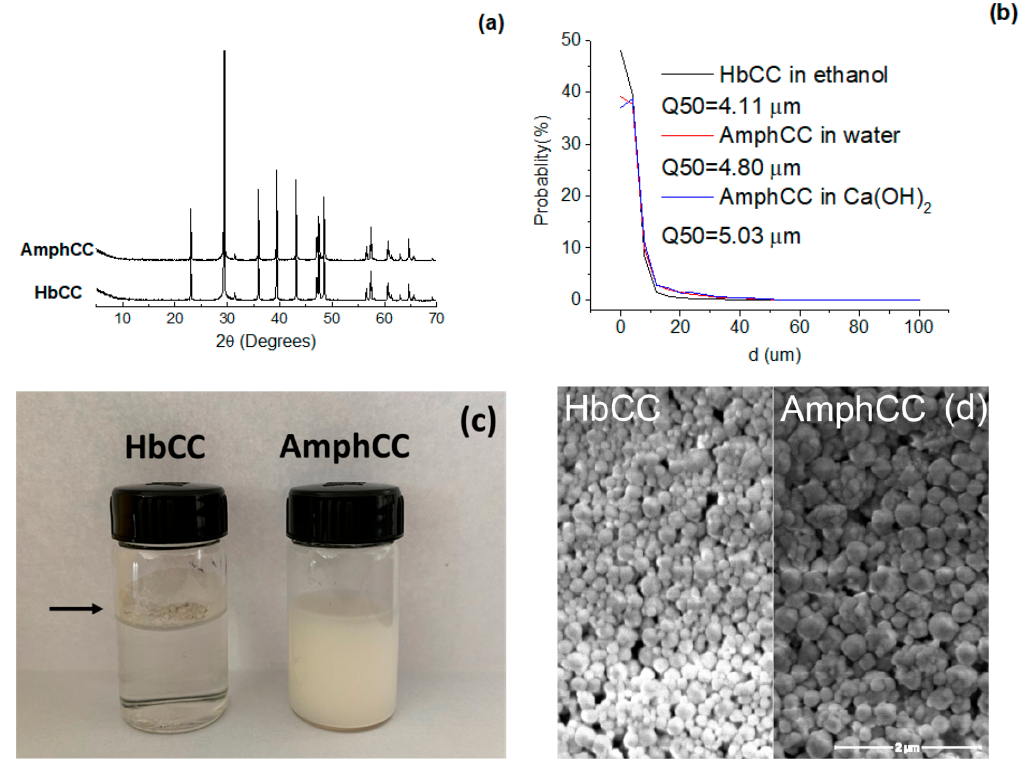
Figure 3. Characterization of the calcium carbonate samples, XRD spectra ( a ), particle size distribution ( b ), macroscopic view in Ca(OH) 2 solution ( c ) and SEM images ( d ). The time-lapse stability variation of AmphCC in the CH solution and comparison with other dispersants is demonstrated in Figure 4. As demonstrated, AmphCC showed the best resistance against sedimentation, with a 72 h relative concentration decline of less than 8%. In contrast, ionic-backboned PC showed little effect in HbCC dispersion, with a 12 h decline of over 85%. The poor performance is due to its highly hydrophilic structure. The dispersion effect of SDS and NPEO-10 was moderate, but still did not match AmphD. Between the two small-molecule dispersants, SDS’s performance was inferior due to side interaction with calcium ions in the solution, while NPEO-10 was limited by its size, making its binding force to HbCC particles less than AmphD and, thus, prone to desorb and destabilize. Additionally, the excessive air entraining effect of small-molecule surfactants may further impede the application potential of SDS and NPEO-10. The results from comparison tests confirmed the superior dispersion effect of AmphCC.